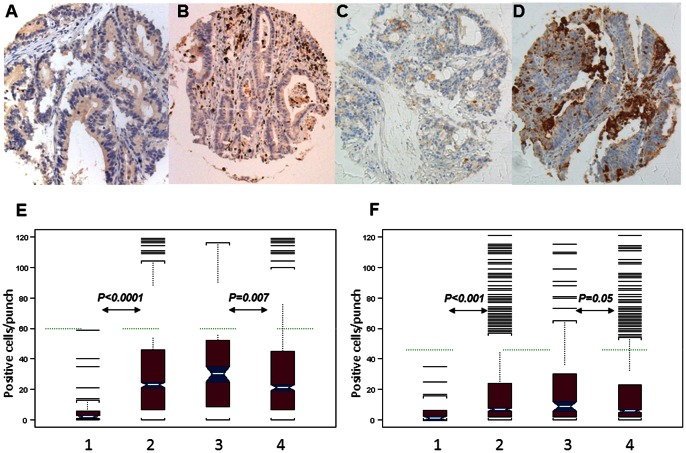
MPO and CD15 specific staining in CRC.CRC samples were stained with MPO and CD15 specific monoclonal antibodies (clone 59A5, Novocastra and clone Carb-1, Leica, respectively). Tumor punches are representative of low (panels A and C) and high (panels B and D) density of CRC infiltrating MPO+ (panels A–B) and CD15+ (panels C–D) cells, respectively. Magnification: 20x. Panel E reports the distribution of MPO+ cells in normal mucosa (E1), total CRC (E2), MMR-deficient CRC (E3) and MMR-proficient CRC (E4). The green line indicates the cut-off of 60 cells/punch as defined by regression tree analysis. Panel F reports the distribution of CD15+ cells in normal mucosa (F1), total CRC (F2), MMR-deficient CRC (F3) and MMR-proficient CRC (F4). The green line indicates the cut-off of 46 cells/punch as defined by regression tree analysis.